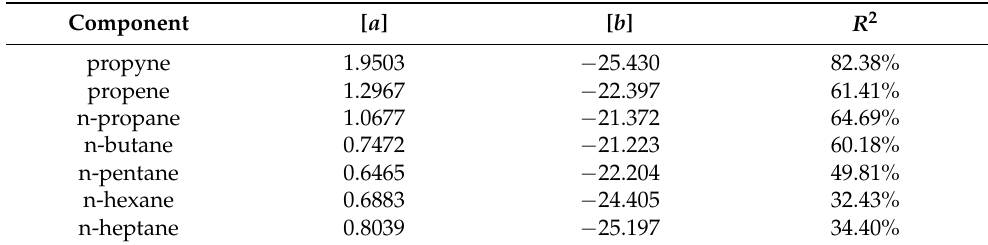
Table 10. Rate constants for the gases in Table 6. Ln k f = [ a ] Log [ ∆ P ] + [ b ], where [ a ] and [ b ] are regression constants.